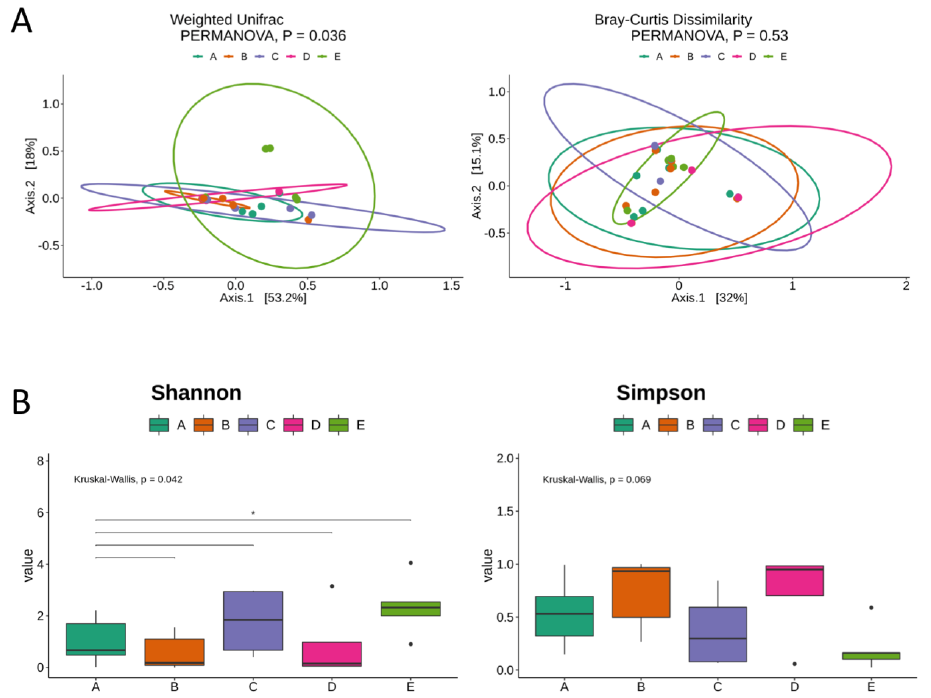
Figure 3. Alpha and beta-diversity analysis. ( A ) Principal coordinates analysis (PCoA) made with weighted UniFrac distances and Bray-Curtis dissimilarity. Sample groups are represented by the letters: A (dark green)-control swab from vaginal fluid; B (orange)-case swab from vaginal fluid; C (purple)-control endometrial tissue; D (pink)-case endometrial tissue; and E (light green)-lesion. ( B ) Alpha diversity indexes of Shannon and Simpson are sowed in the boxplots for each collection site group of samples (A, B, C, D and E). Kruskall-Wallis and Wilcoxon tests are showed for group and paired groups comparison, respectively (represented by solid lined above boxplots, only significative comparisons were shown and marked with an *). Black solid points represent outlier samples.